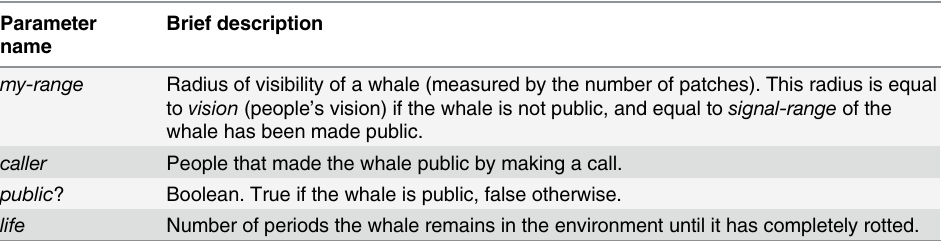
Table 3. Whale state variables.